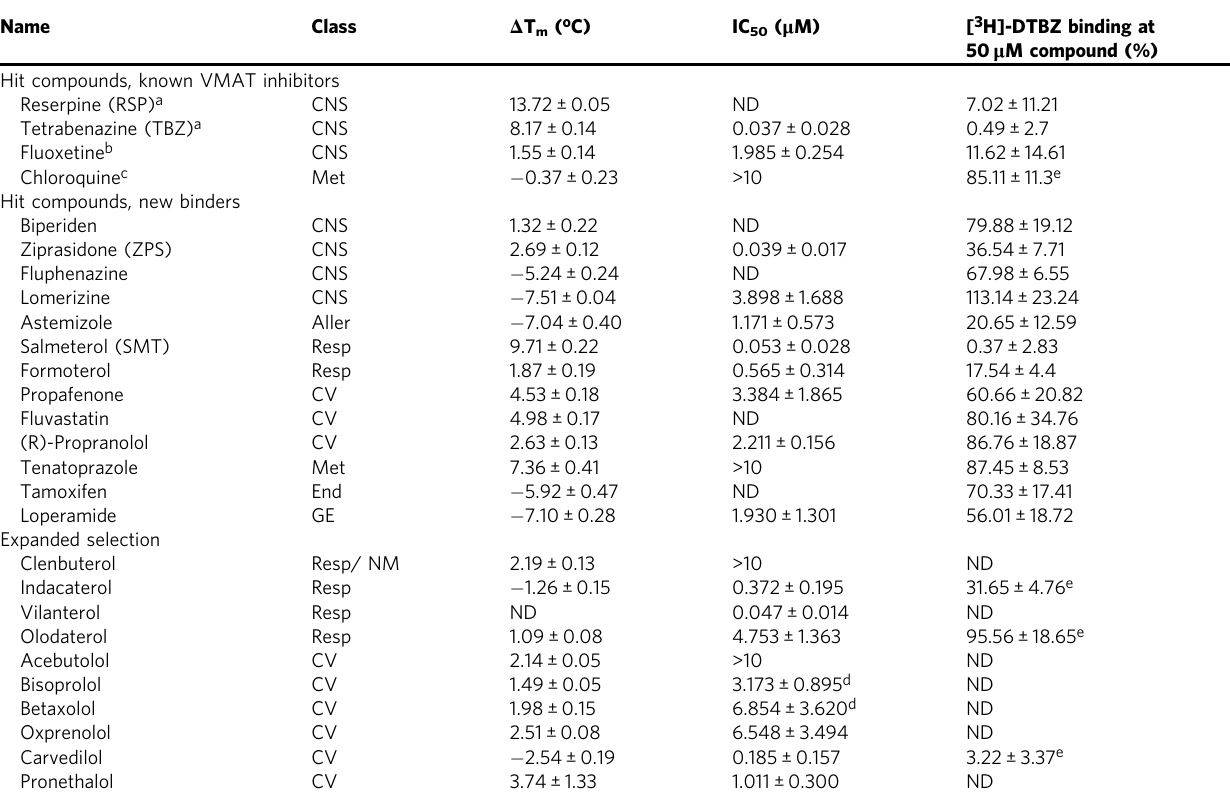
Table 1 Validated primary hits of VMAT2 binders, with Δ T m -values from DSF screening, as well as IC 50 values for VMAT2 inhibition (FFN206 uptake) and competition of [ 3 H]-DTBZ binding in